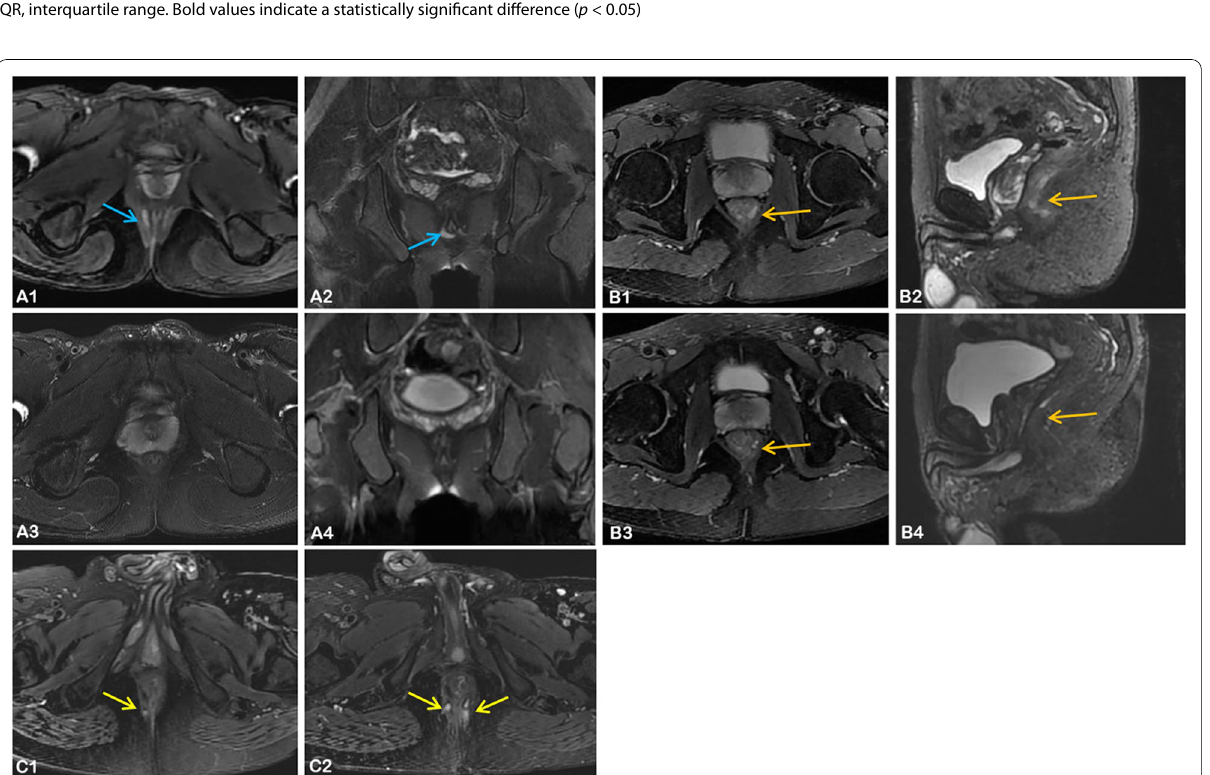
IQR, interquartile range. Bold values indicate a statistically significant difference ( p < 0.05)